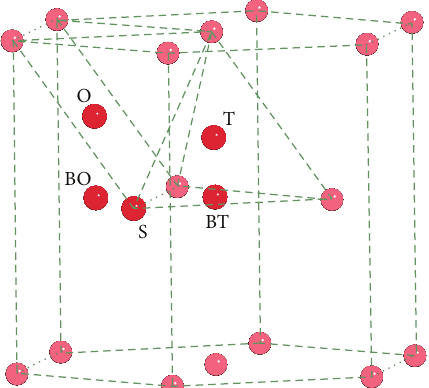
Figure 1: Five crystallographically unique interstitial sites in 𝛼 - zirconium (hcp structure), where the pink spheres are the hcp lattice sites and the red ones are labeled as octahedral (O), basal octahedral (BO), tetrahedral (T), basal tetrahedral (BT), and substitutional (S) sites,